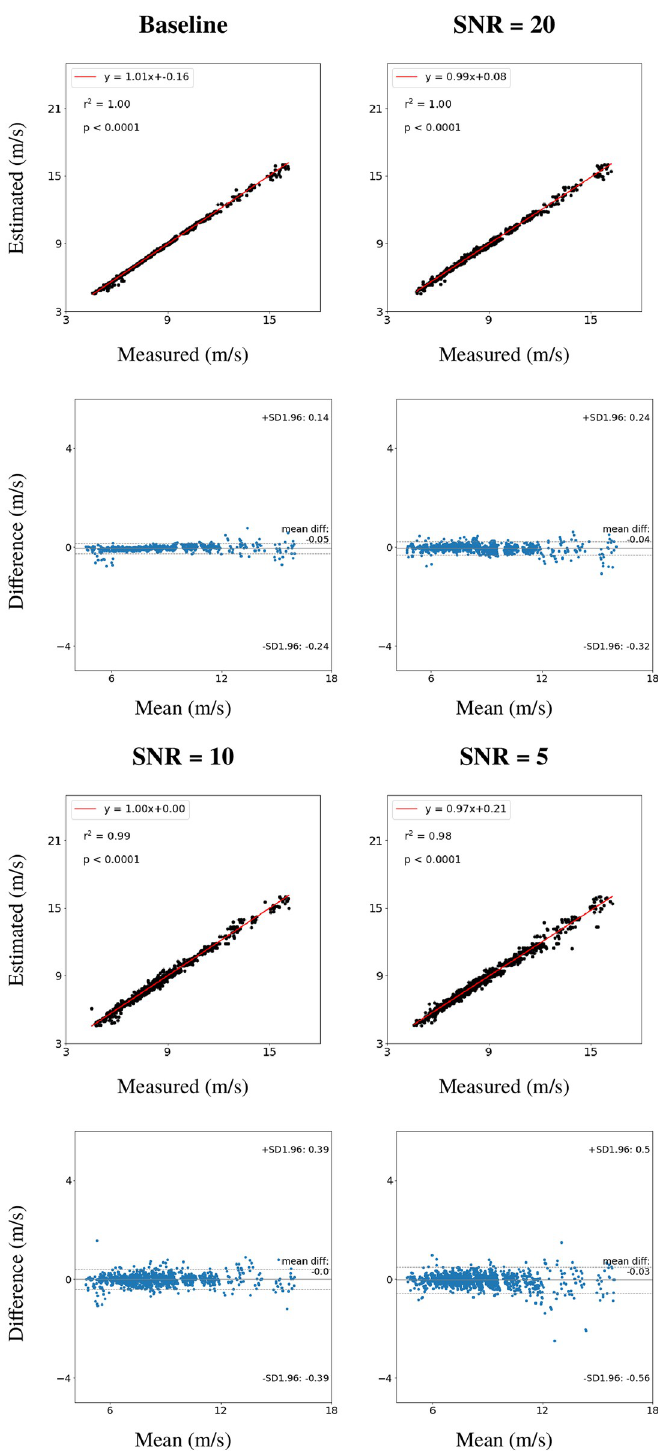
Fig 5. Estimation of PWV on a hold-out test set containing 1312 virtual subjects using the recurrent neural network, with different levels of added white noise. Estimated against measured PWV with the linear regression line in red, the coefficient of determination, r 2 , and the p-value (top). Corresponding Bland-Altman plots (bottom). SNR: signal to noise ratio.